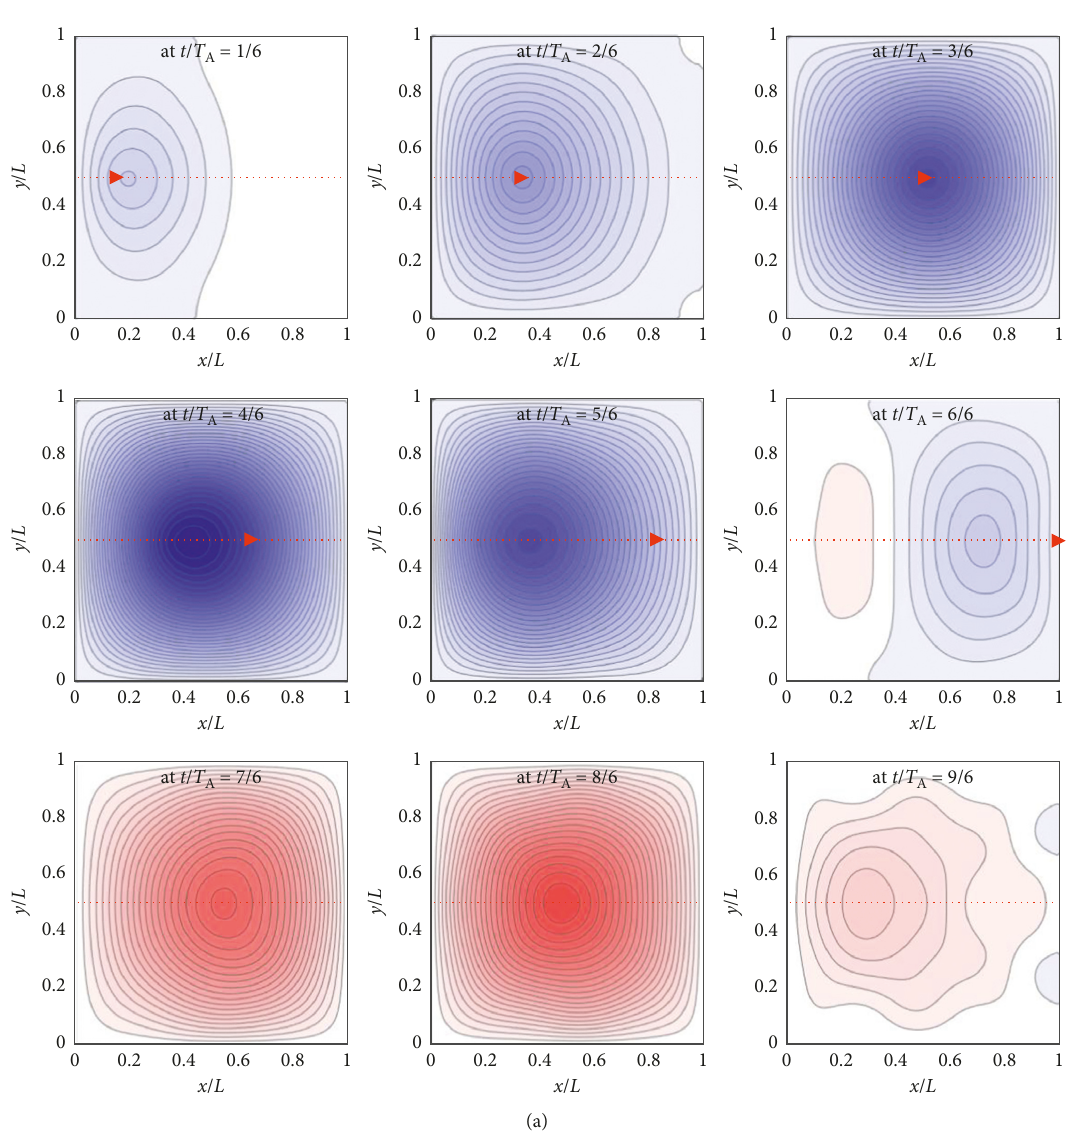
3.5 L , Y 0.5 L (cid:31) (cid:31)